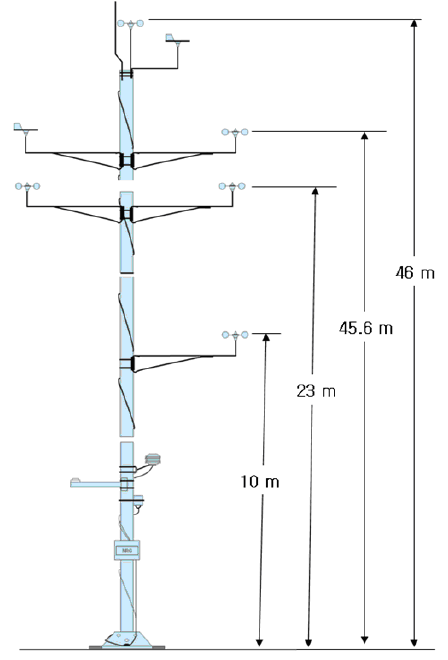
Figure 7. Meteorological mast installed at the Dawanryung test